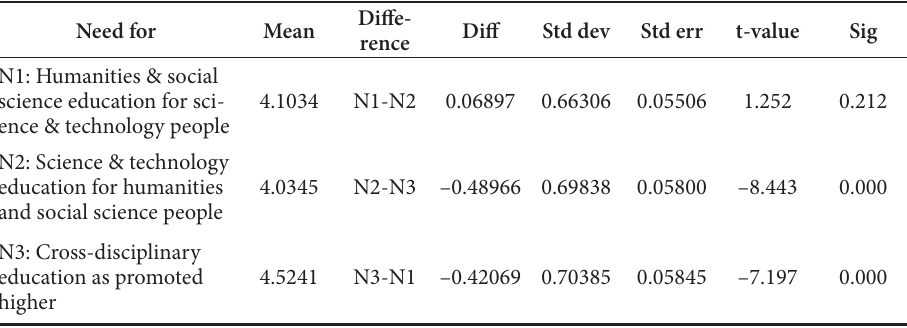
Table 9. Need for cross-disciplinary training Need for Mean